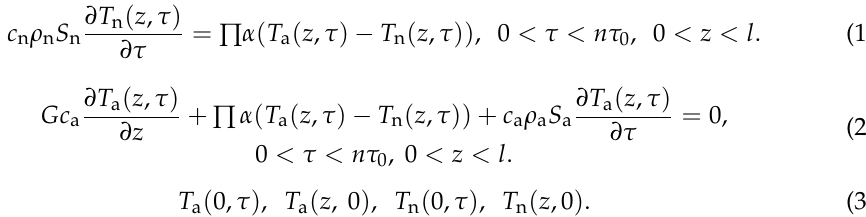
Figure 2. Cross-section of the four adjacent nozzle channels: S n and S a are the nozzle and air passage cross-sectional areas. The problem (1)–(2) with the given boundary conditions, (3) has been solved numer- ically using the finite difference method. The results of the solution can be found in [13]. It is known that SSRHEs are characterized by a laminar air flow regime in the nozzle channels [13]. When analyzing the results of the numerical solution of the model, it was revealed that the air temperature changes approximately linearly along the length of the channel, this corresponds to the conditions q = const ( q is heat flow density on the channel wall). Therefore, the use of expression (5) to determine the Nusselt number is justified. It should be noted that, for the diameter of a single nozzle channel, d = 0.0016 m correspond- ing to the test sample, and the length of the initial thermal stabilization section is about 1/4 of the channel length, which, with a sufficient degree of accuracy, allows taking Nu ≈ 4.36. In order to validate the numerical solution results of the developed mathematical model, an experimental installation “SSRHE Temperature Conditions Research” has been